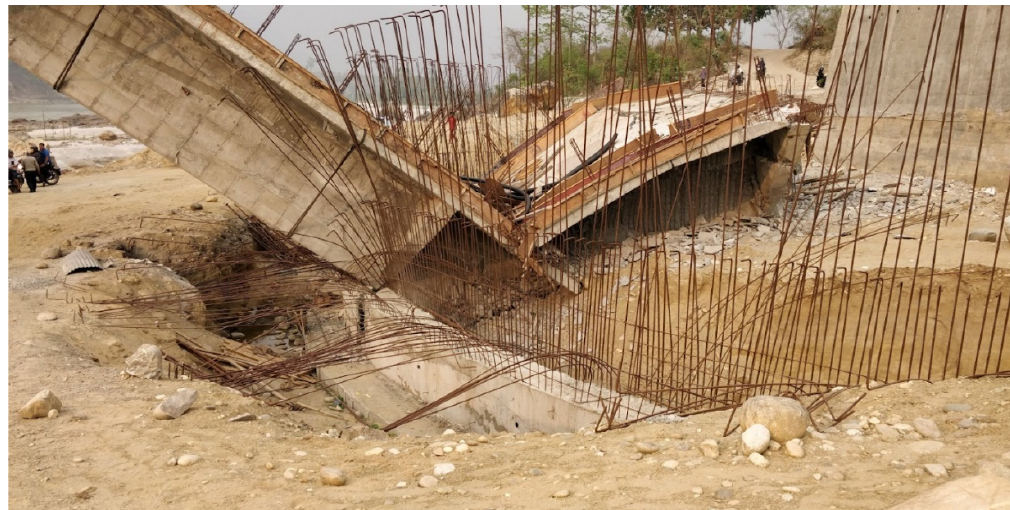
Figure 6. Collapsed Span-1 of the bridge.